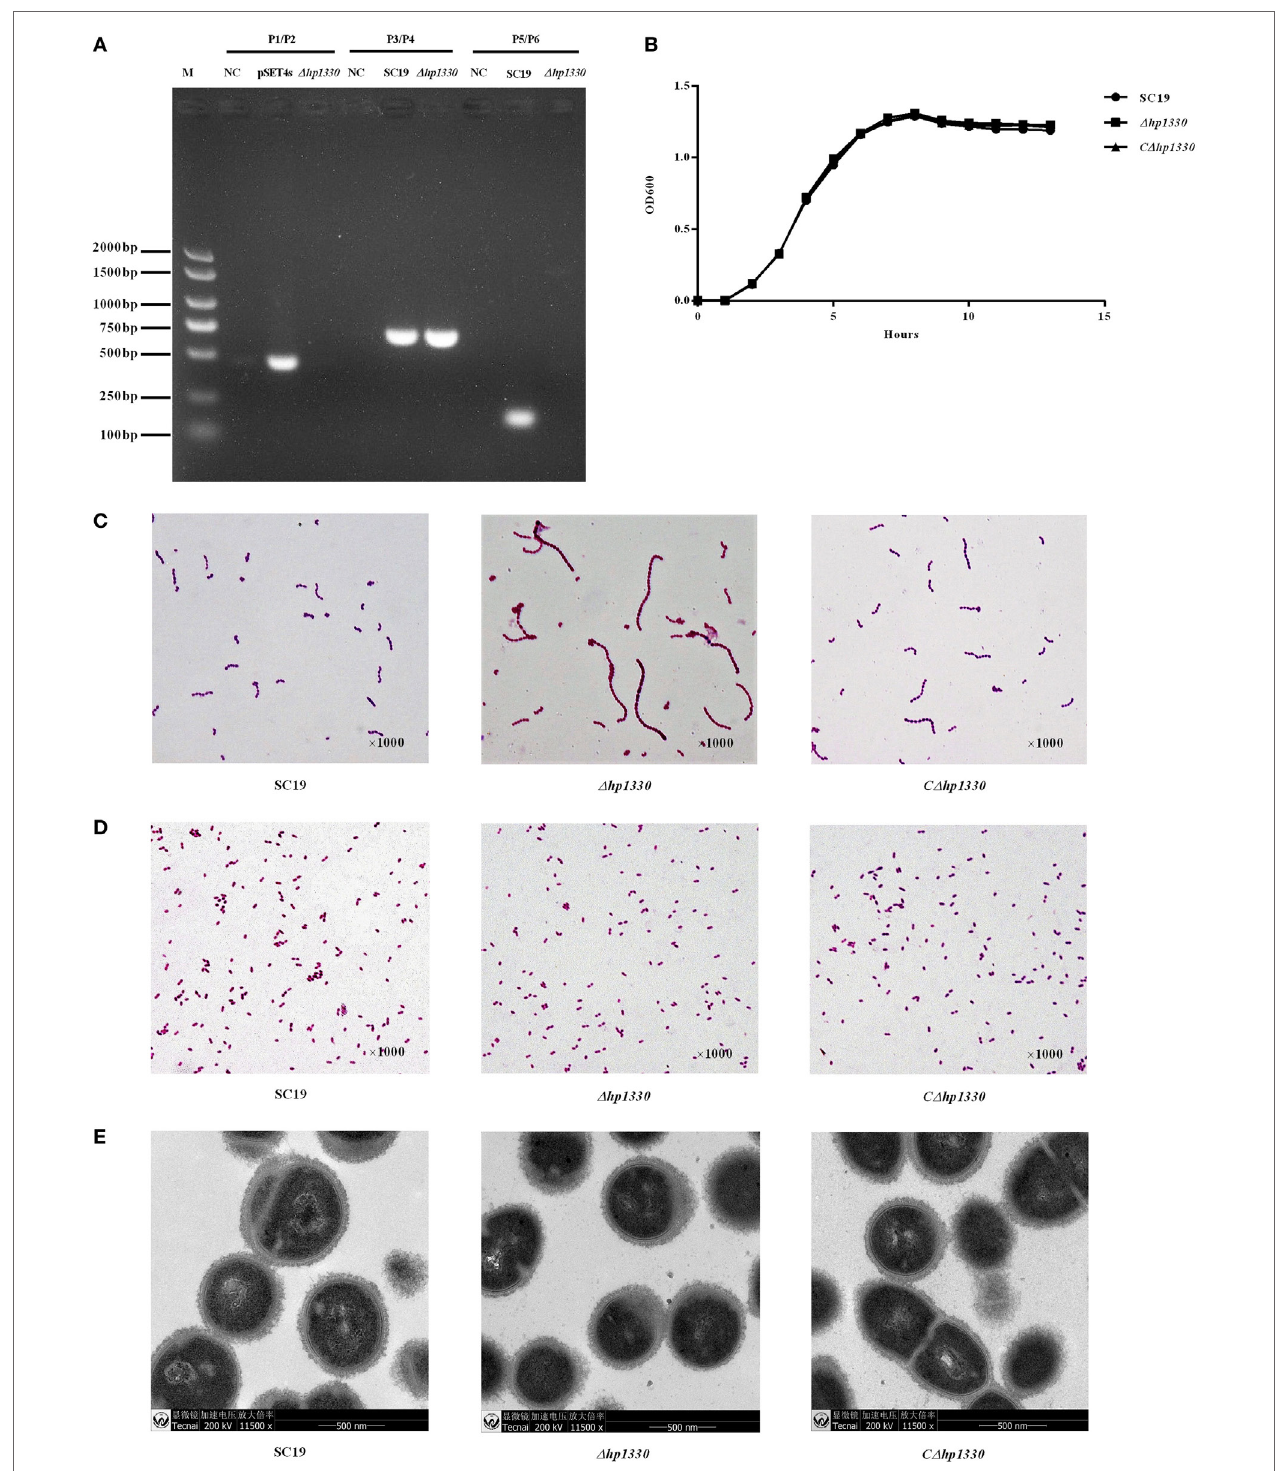
FigUre 4 | Construction and confirmation of the Δ hp1330 mutant. (a) Confirmation of the Δ hp1330 mutant by PCR using the primers pairs P1/P2 (to detect the pSET4s vector), P3/P4 (to detect the gdh gene), and P5/P6 (to detect the hp1330 gene). (b) Growth curves of the SC19, Δ hp1330 , and C Δ hp1330 strains. The bacteria were cultured in tryptic soy broth (TSB) containing 5% newborn bovine serum at 37°C. The absorbance at 600 nm was measured at intervals of 1 h. Results shown are representative of three independent experiments. Light microscope morphology of the SC19, Δ hp1330 , and C Δ hp1330 strains were observed by Gram staining ( × 1,000) following culture in panel (c) TSB or in panel (D) tryptic soy agar. (e) The capsules of SC19, Δ hp1330 , and C Δ hp1330 strains were detected by transmission electron microscopy ( ×